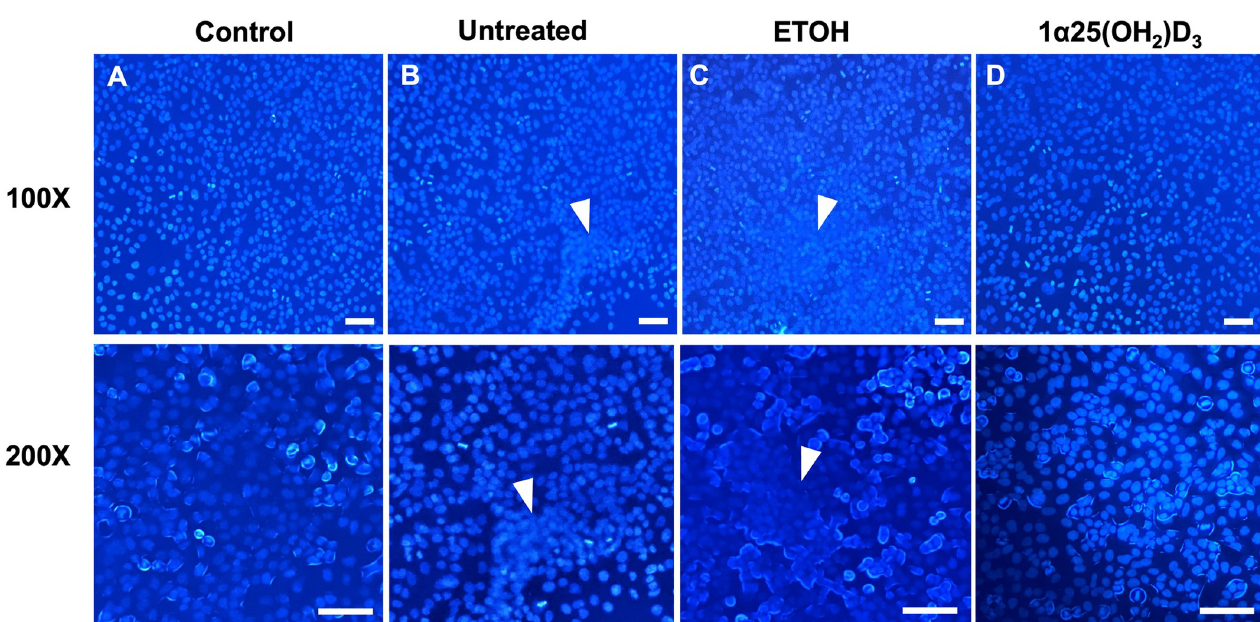
Fig 6. Confirmation of MNGC reduction in 1 α ,25(OH) 2 D 3 -pretreated A549 cells during B . pseudomallei infection. A549 cells without B . pseudomallei were used as a negative control (A). Untreated (B), ETOH-pretreated (C) and 1 α ,25(OH) 2 D 3 -pretreated (D) A549 cells were infected with B . pseudomallei at MOI 1 for 12 h. Cells were then fixed and stained with DAPI (blue). The white arrows indicate the formation of MNGCs. Scale bar = 100 μ m.